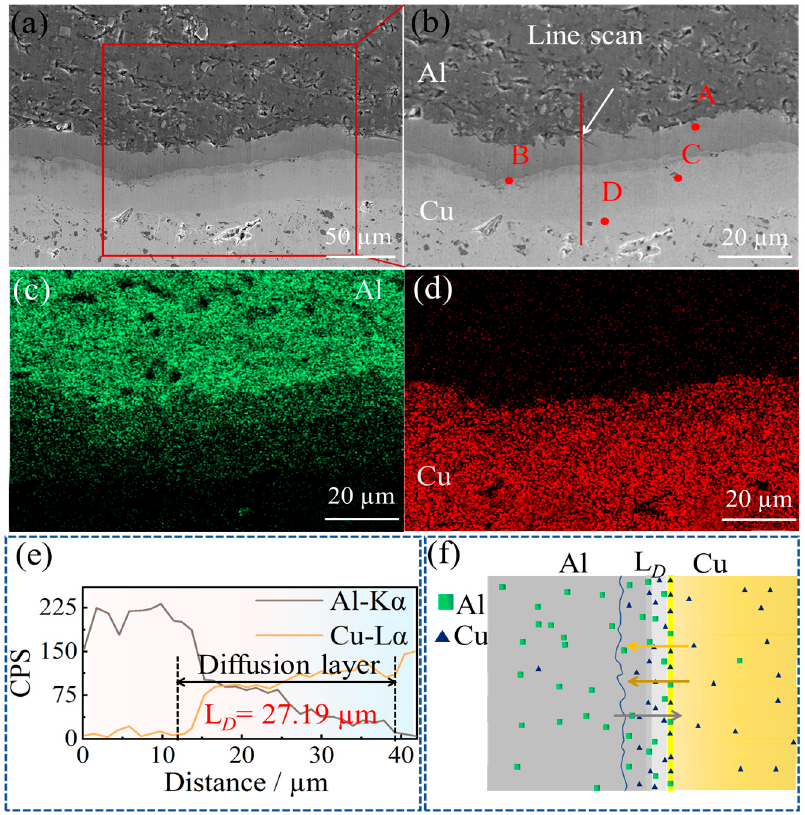
Figure 7. ( a ) SEM images of diffusion layer morphology; ( b ) SEM image of the sample surface scanning area and A, B, C, D are point scanning areas; ( c ) Distribution of Al elements; ( d ) Distribution of Cu elements; ( e ) Sample line scan area and energy spectrum; ( f ) Cu and Al diffusion diagram.